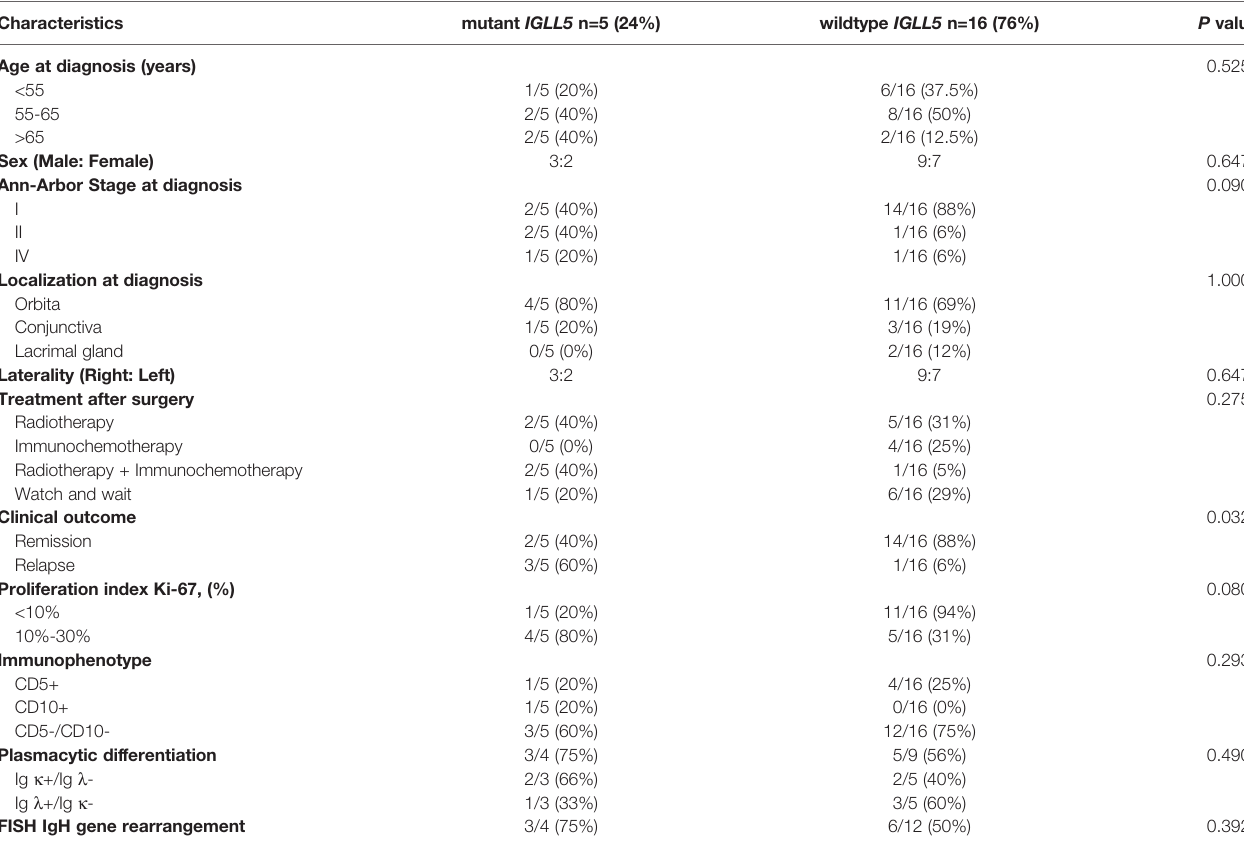
TABLE 2 | Comparisons of clinical course according to OAML patients with or without IGLL5 mutation.